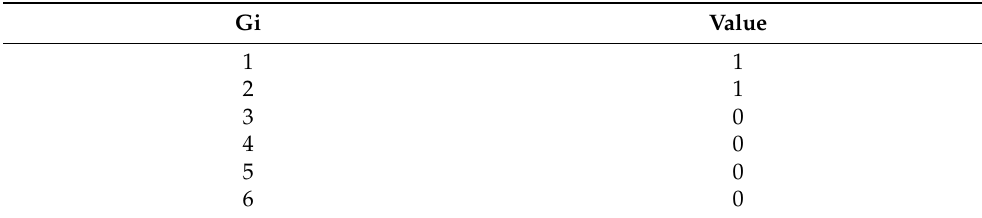
Table 6. Optimal value of binary variable G i . Gi